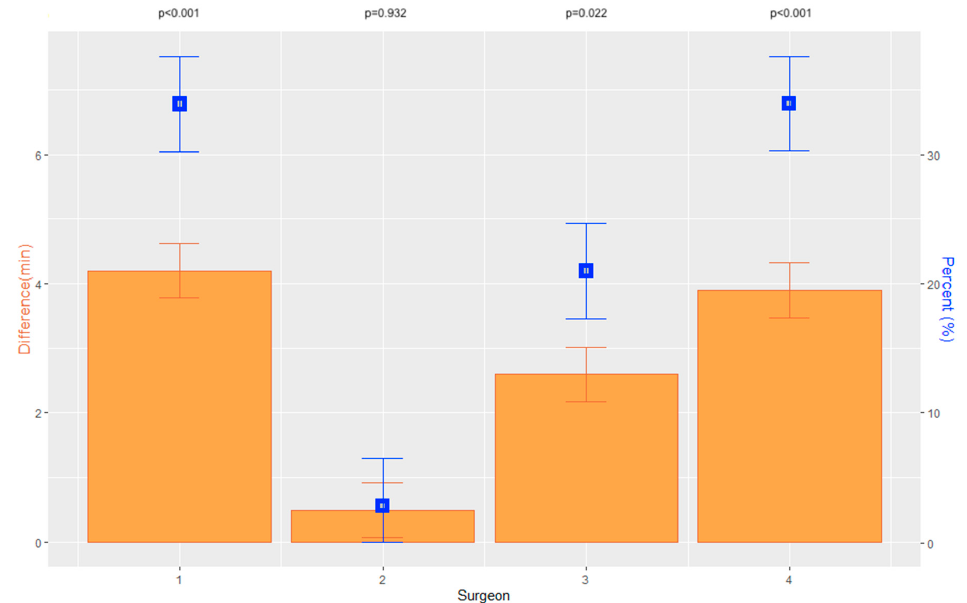
Figure 3. Graphs displaying the absolute difference of graft preparation time of each surgeon between periods 1 and 2 in minutes, including the standard error and p -values as well as the percentage difference for each surgeon.